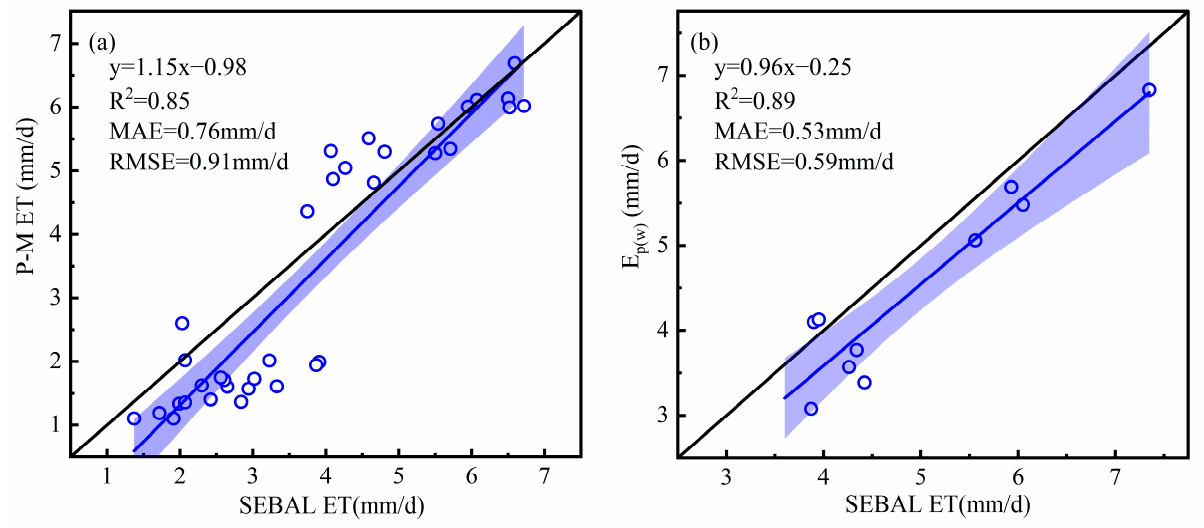
Figure 3. Comparison of SEBAL ET with ( a ) P - M ET and ( b ) E p(w).